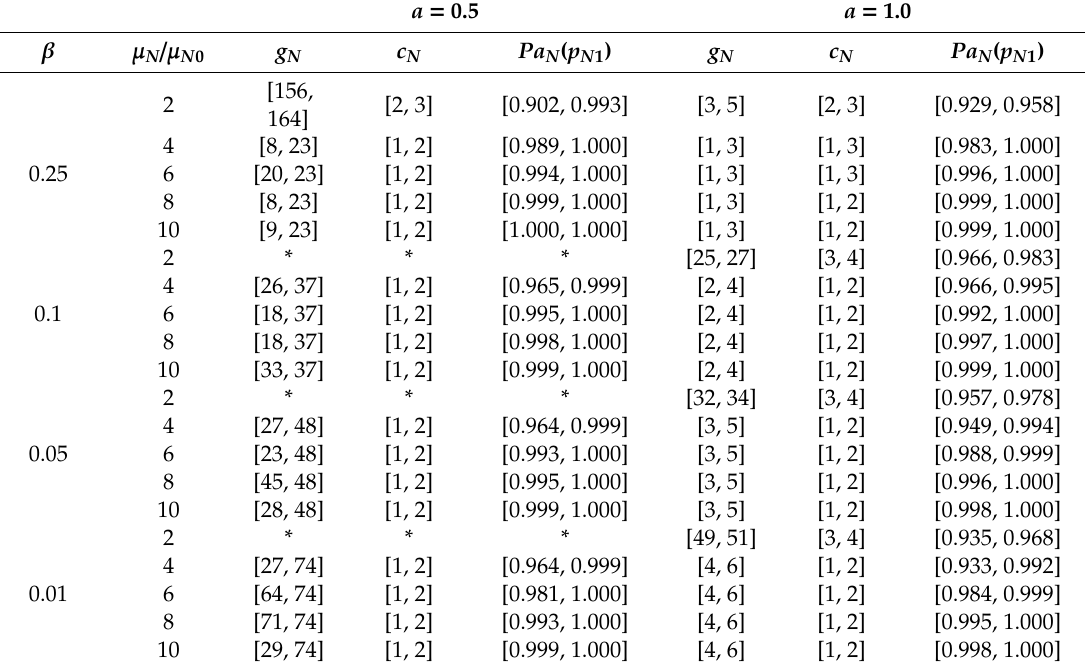
Table 4. Optimal parameters of the proposed GASP under neutrosophic statistics when r N = [4, 6] and δ = [1.9, N